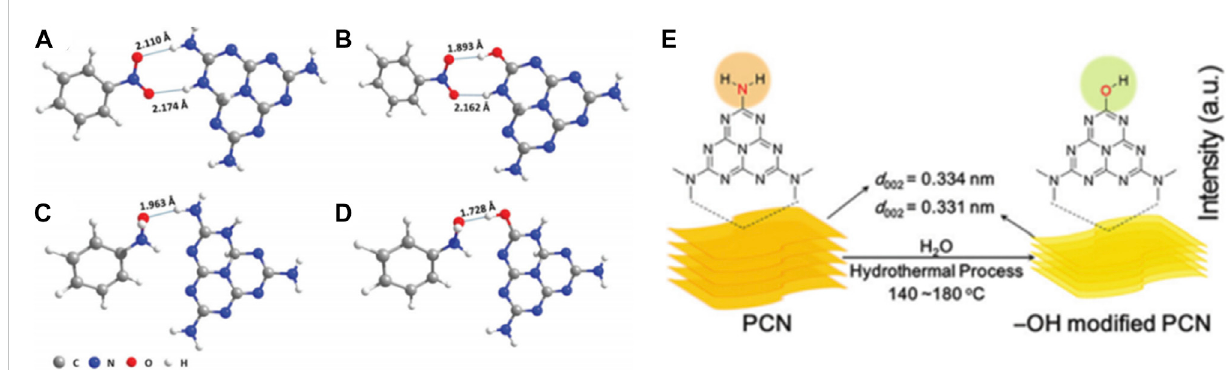
FIGURE 10 Reaction mechanism model diagram. (A, C) The best adsorption states of nitrobenzene and PHA on PCN, (B, D) the best adsorption states of PCN modi fi ed by -OH for nitrobenzene and PHA (where the numbers indicate the length of hydrogen bond), and (E) schematic diagram of hydroxyl modi fi ed PCN. Reproduced with permission from reference (Pei et al., 2021).